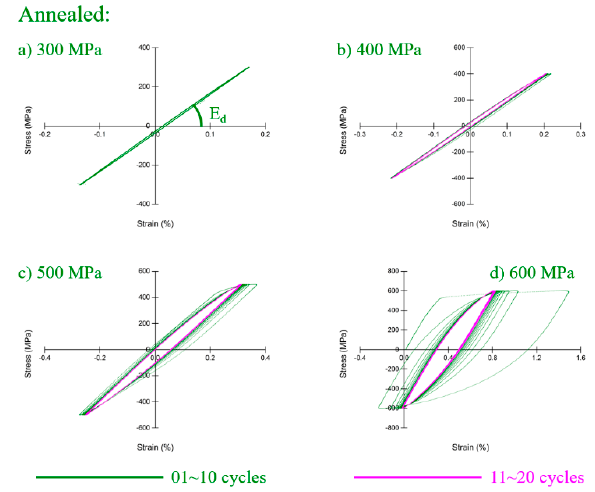
Figure 5. Hysteresis loop of annealed Inconel 718 ( σ 0.2 = 539 MPa): at ( a ) 300 MPa; ( b ) 400 MPa; ( c ) 500 MPa; ( d ) 600 MPa.